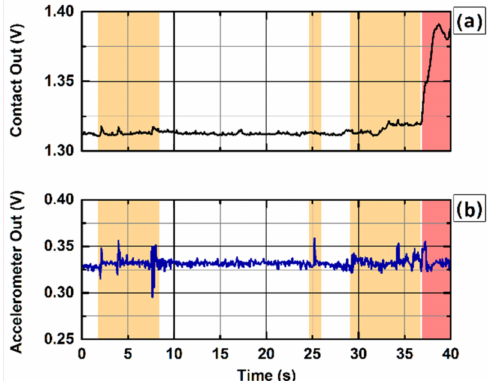
Figure 8. Contact ( a ) and motion ( b ) analog signals acquired with the probe V2 during a diffuse correlation spectroscopy measurement performed on an ELGA baby. It shows a 40 s extract of data acquired while the baby was moving and crying (orange-shaded areas) leading to probe detachment (red-shaded area). Motion artifacts may severely impact the optical data quality, and the capability to identify them during post-processing can be effectively used to mitigate their detrimental effect